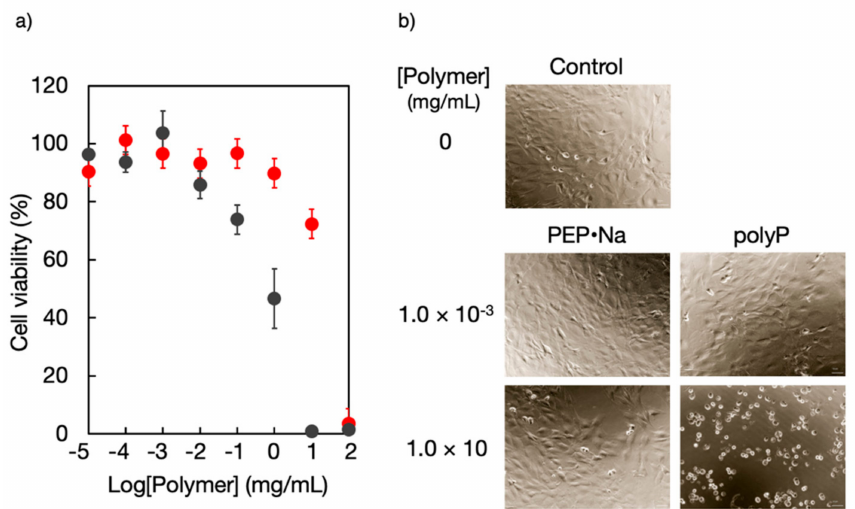
Figure 6. ( a ) Viability and ( b ) morphology of MC3T3-E1 cells following contact with